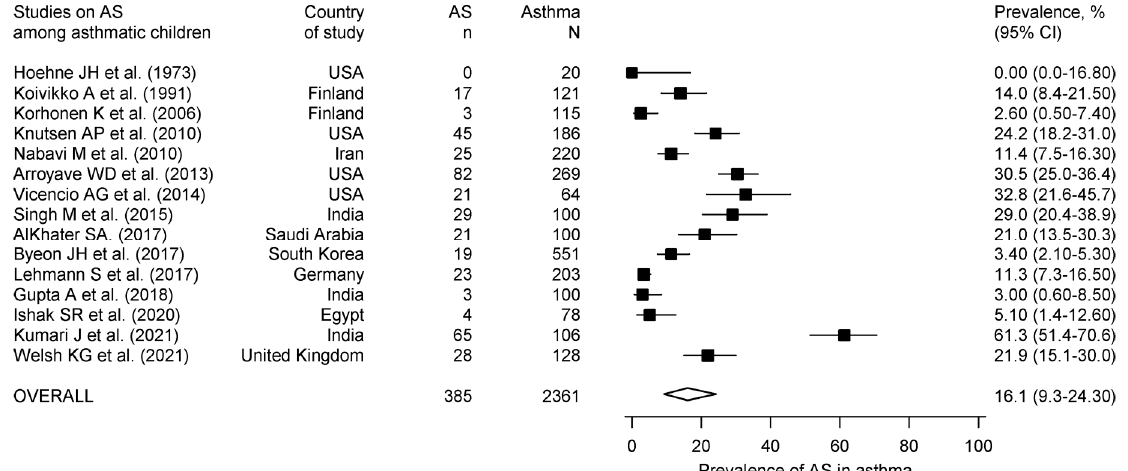
Figure 2. Forest plot for the pooled prevalence of aspergillus sensitization in asthmatic children. The prevalence reported in the individual studies is represented by the black square with horizontal bars indicating the 95% confidence interval. The diamond at the bottom refers to the pooled prevalence with a 95% confidence interval [9,39,41–53].